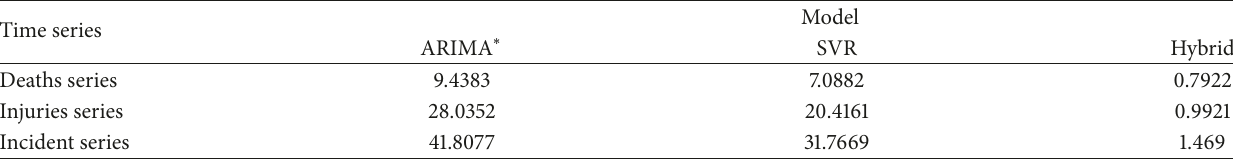
Table 1: Some reports of mean square error for fitting and forecasting the series.